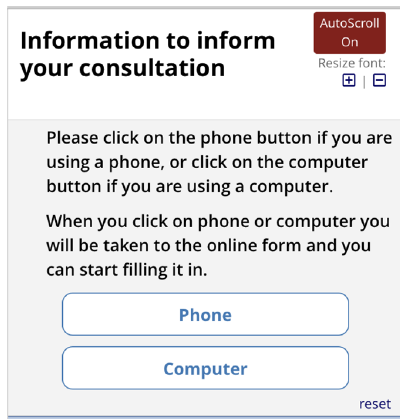
Figure 10. Pre-consultation form: Selection of phone or computer.